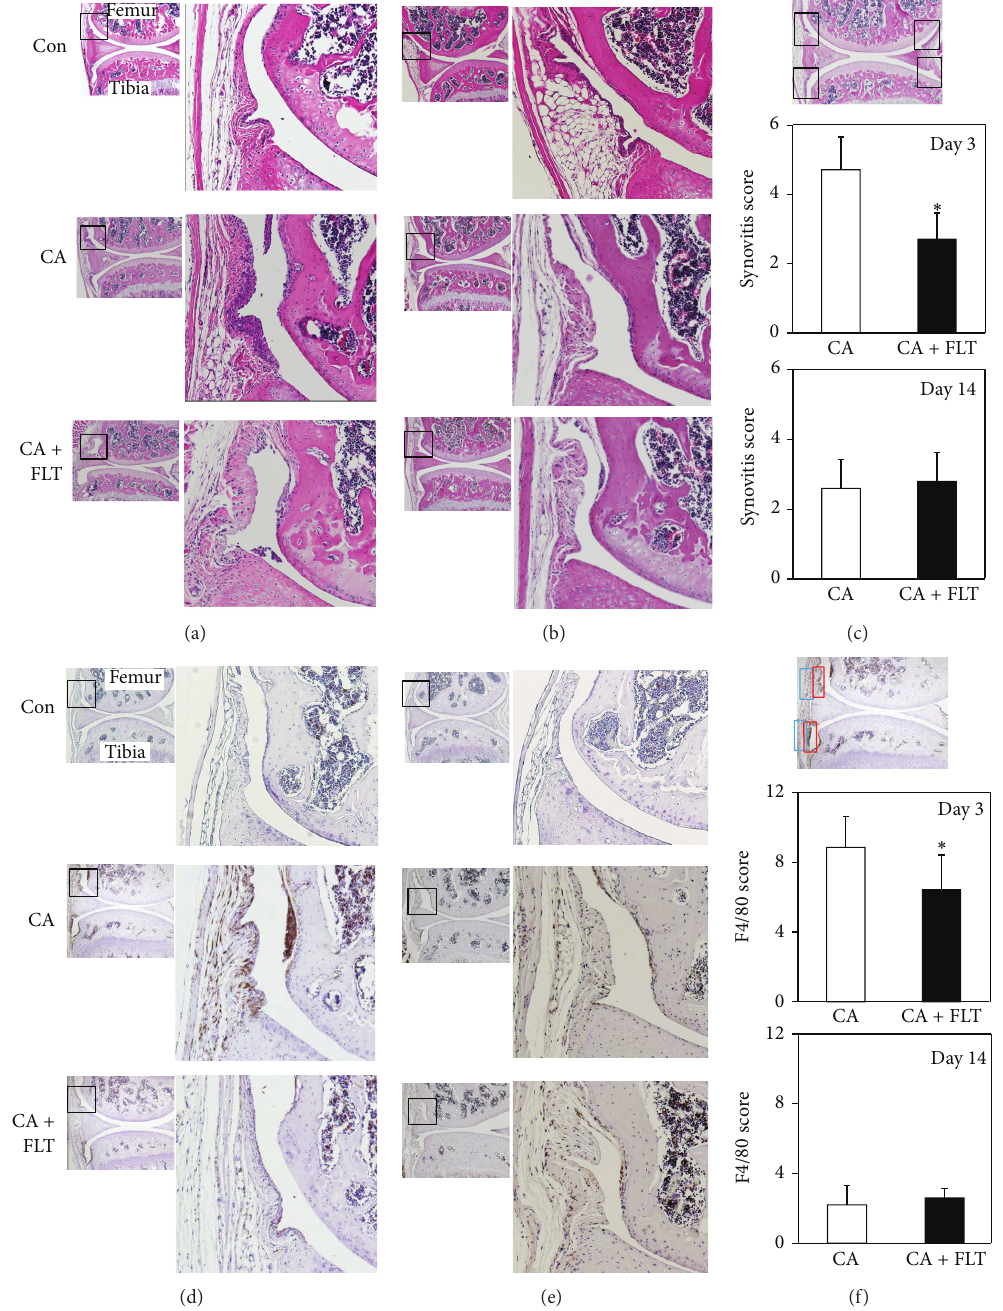
Figure 2: Histological analyses of synovial inflammation induced by carrageenan. (a, b) H&E staining of sagittal sections of mice knee joints at day 3 (a) and day 14 (b) after carrageenan injection. Boxed areas in the left panels are magnified and presented in the right panels. CA: carrageenan group; CA + FLT: carrageenan + follistatin group; Con: control group. Magnification: left × 40, right × 100. (c) Semiquantitative analyses of synovial inflammation. The severity of synovial inflammation was evaluated according to the synovitis scoring system ( Synovitis Score ( Blom et al., osteoarthritis and cartilage, 2004 [20])). The synovitis scores are indicated as the total of four different areas in the knee joint as denoted in upper panel. ( ∗ 𝑃 < 0.05) . (d, e) Immunohistochemical analyses of macrophage infiltration into synovial membrane at day 3 (d) and at day 14 (e) after carrageenan injection. Sagittal sections of mice knee joints were stained with F4/80 antibody. Sections were counterstained with hematoxylin. Boxed areas in the left panels are magnified and presented in the right panels. CA: carrageenan group; CA + FLT: carrageenan + follistatin group; Con: control group. Magnification: left × 40, right × 100. (f) Semiquantitative analyses of the degree of F4/80-positive macrophage infiltration into synovial membrane ( F4/80 Score ( Willis et al., JOI, 2012 [22])). The scores were indicated as the total of four different areas of the synovial membrane (superficial layer (boxed by red) and deep layer (boxed by blue) of suprapatellar or infrapatellar region) as described in the upper panel ( ∗ 𝑃 < 0.05)